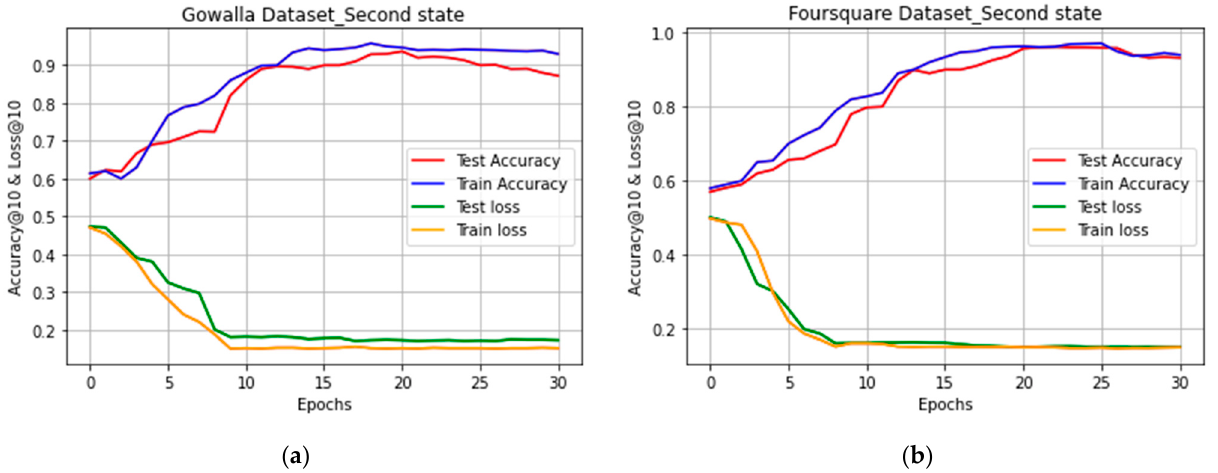
Figure 9. Training and testing accuracy @10 and loss @10 for two datasets vs. epochs in the second state of experiments. ( a) Gowalla dataset; ( b ) foursquare dataset.